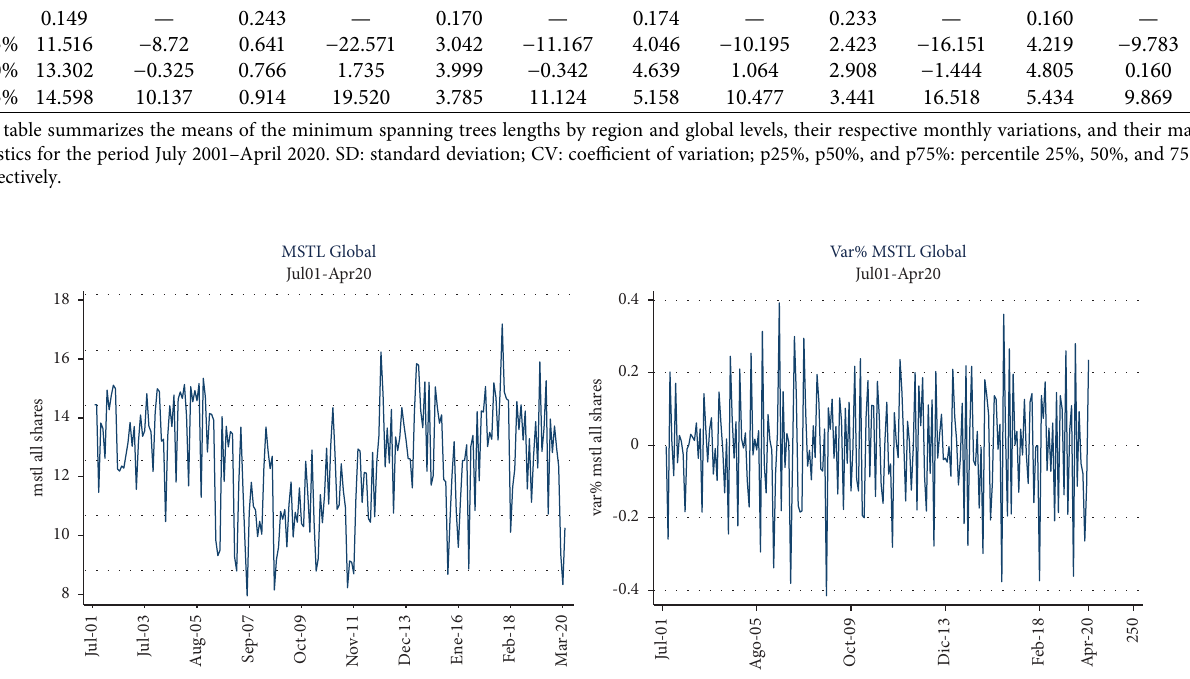
Figure 1: Global minimum spanning tree length (MSTLG). This figure represents the evolution and variation of the minimum spanning tree length for a total of 27 stock indexes in North and Latin America, Europe, Asia, and Oceania for the period July 2001–April